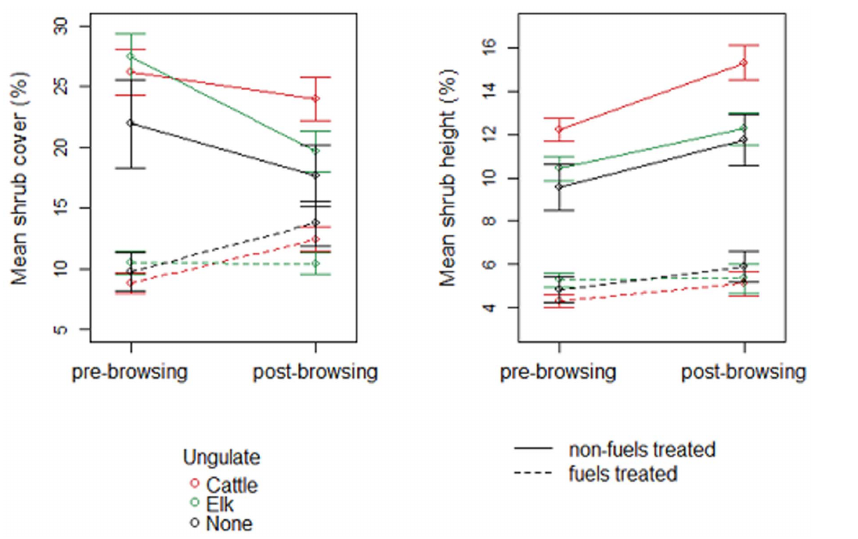
Figure 2. Pre and post (six years following initiation) browsing treatment initiation values for shrub cover and height of study paddocks. Mean and standard error are shown for paddocks browsed by cattle and elk, and un-browsed paddocks, at non-fuels treated and fuels treated sites seperately.